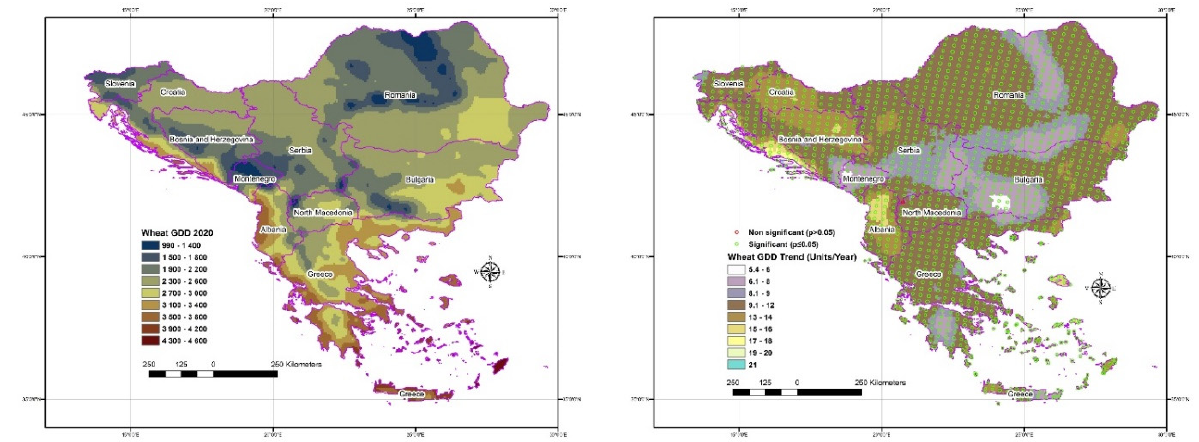
Figure 8. The GDD distribution for the wheat cultivation in 2020 ( left ) and the GDD trend with statistical significance marks ( right ).